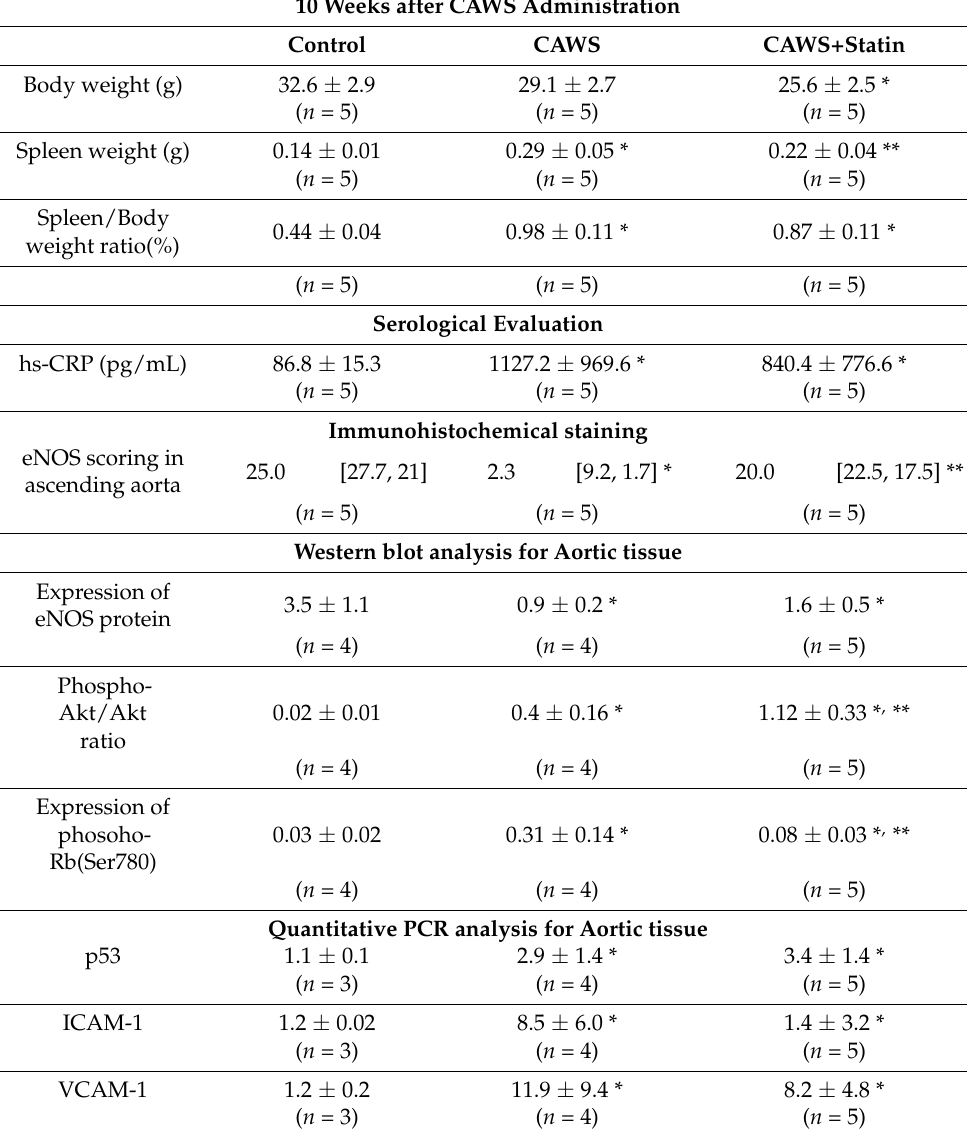
Table 1. Summary of the data collected 10 weeks after Candida albicans water-soluble fraction (CAWS)